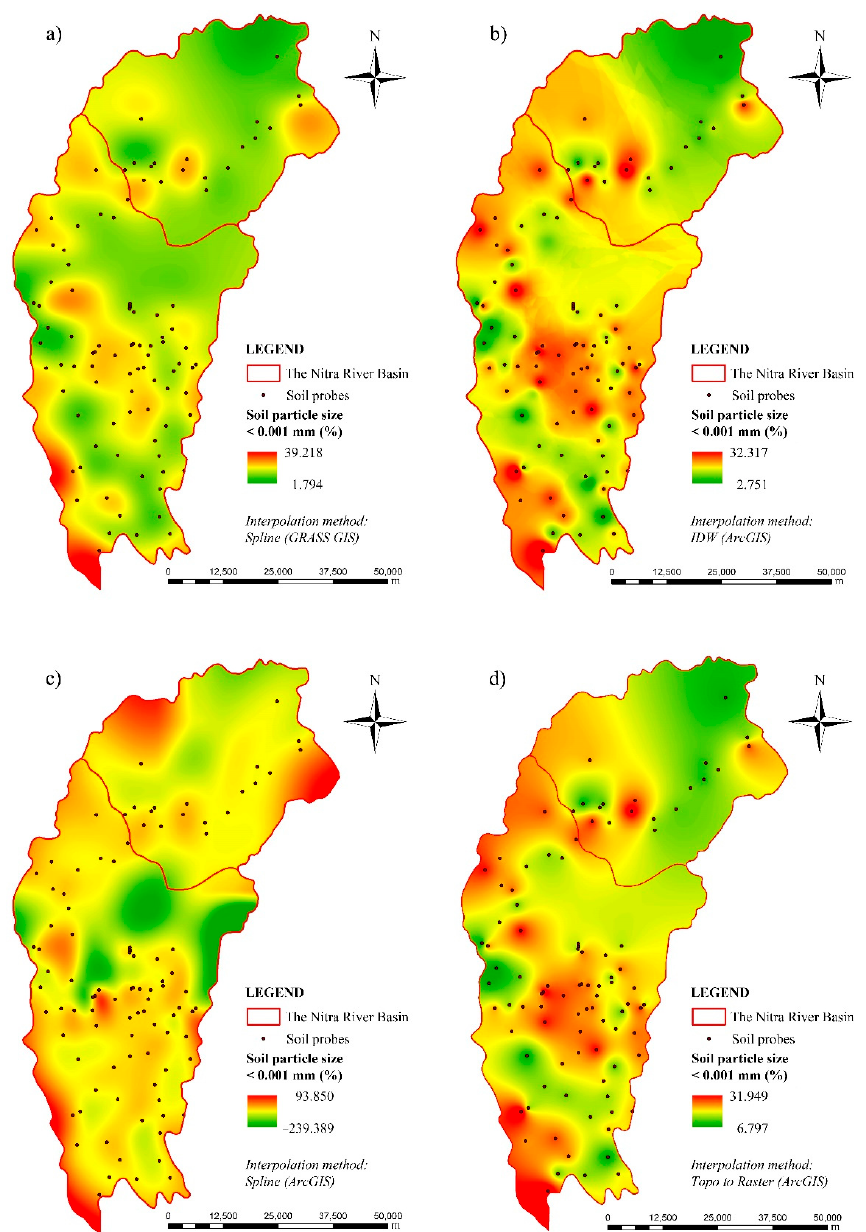
Figure 4. Spatial distribution of clay fraction content <0.001 mm according to used interpolation methods: ( a ) Spline (GRASS GIS); ( b ) IDW (ArcGIS); ( c ) Spline (ArcGIS); ( d ) Topo to Raster (ArcGIS). Representation of the clay fraction (CFC) (content of particles with diameter <0.001 mm) was also expressed in %. The input CFC from 112 sampling points ranged from 6.8–32.4%. Once again, the interpolation method Topo to Raster resulted in dataset with the narrowest range of the values (6.8–31.9%) (Figure 4). However, a similar maximum value was ob- served also for the IDW method. The minimum value was closer to dataset obtained after interpolation using Spline in GRASS GIS (values in the range 1.8–39.2%). The range of the dataset obtained by Spline in GRASS GIS was wider than for IDW and Topo to Raster methods (in the range 1.8–39.2%) but again, the values were all above zero. After using Spline (ArcGIS), the interpolated values were again in a very wide range from − 239.4% up to 93.9%, including also incorrect negative values of